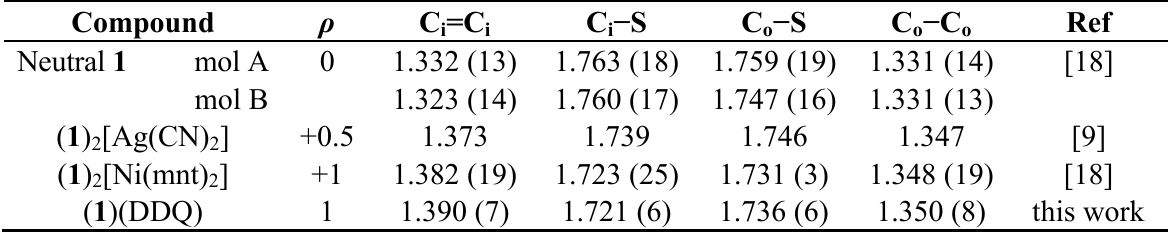
Table 1. Intramolecular bond lengths (in Å) in the TTF core of 1 (averaged values). The formal charge of each molecule is given as ρ , C the TTF core.